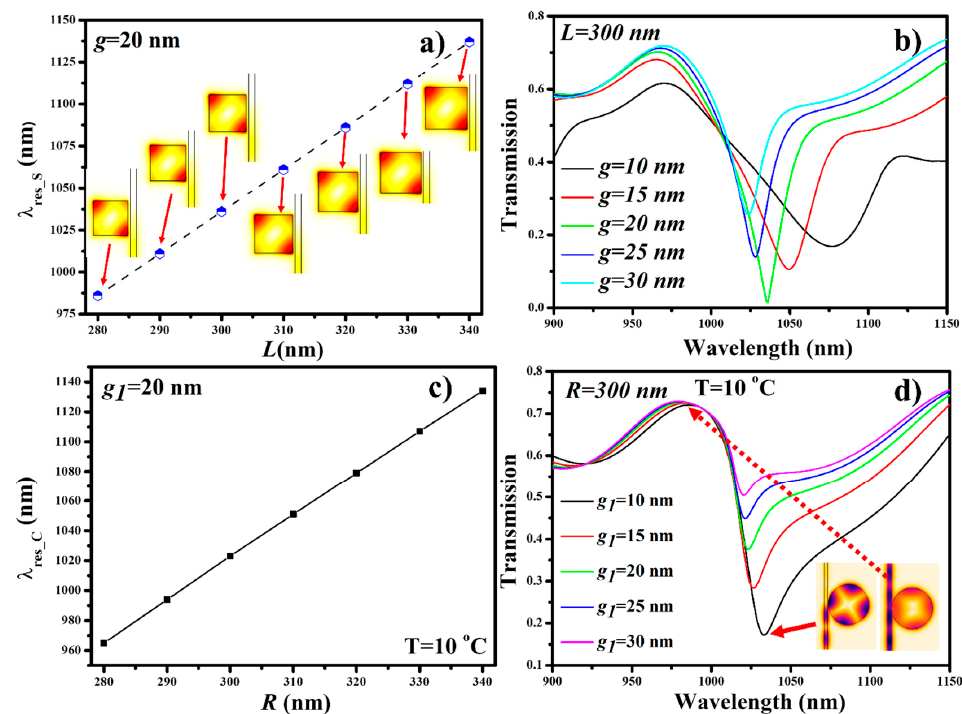
Figure 4. Spectral characteristics of square and circular cavity: ( a ) λ res_S versus L , ( b ) effect of g on transmission, ( c ) λ res_C versus R , and ( d ) effect of g 1 on transmission.